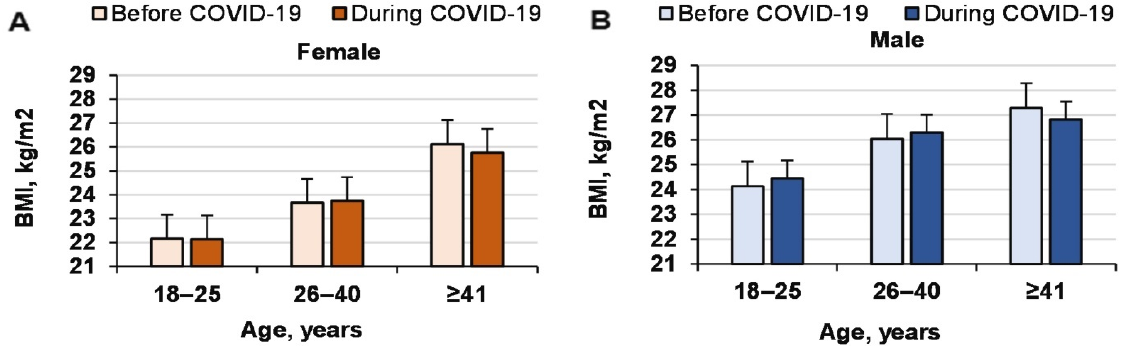
Figure 4. Changes in BMI before and during COVID-19 for men and women of different ages. Table 4. Changes in BMI distribution during COVID-19.